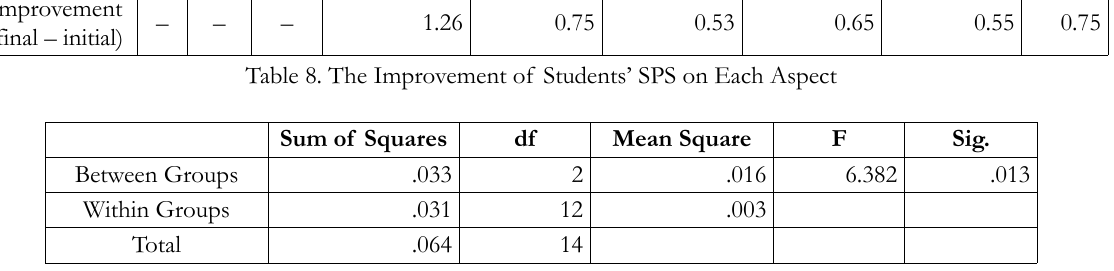
Table 9. The ANOVA Test Result of Students’ SPS